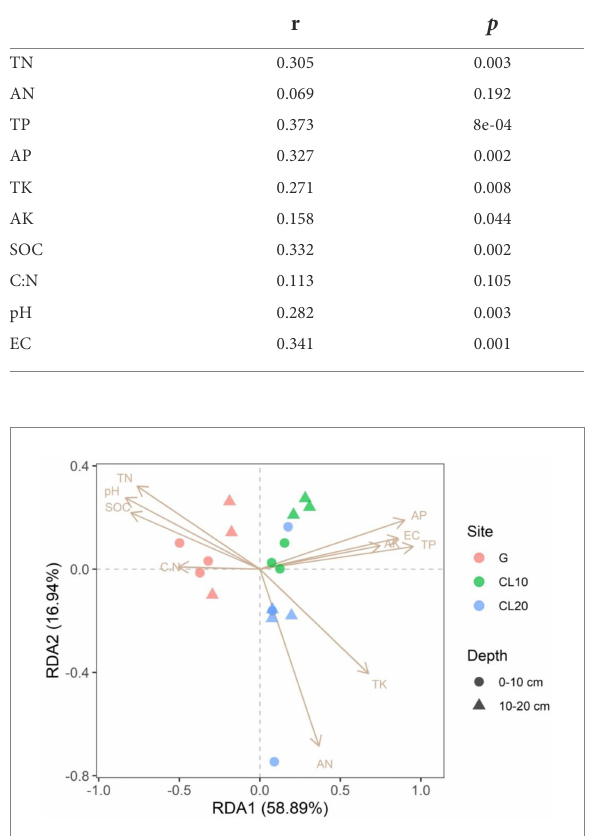
TABLE 3 Mantel test of the effects of soil properties on bacteria community composition under different land use types and depths.